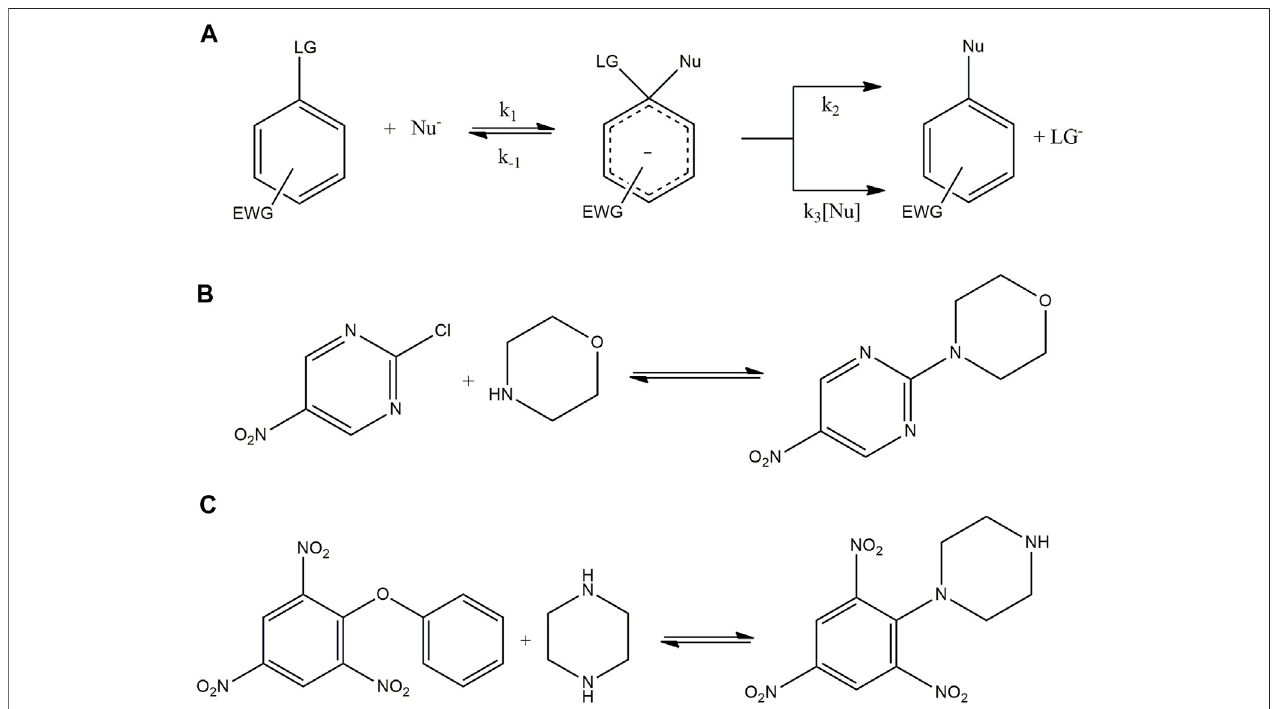
FIGURE7|(A) Generalmechanismforanucleophilicaromaticsubstitution.Thesubstratehasaleavinggroup(LG)andsomeelectronwithdrawinggroup(EWG)to favor the substitution. The nucleophile (Nu) attaches to the ring to form the Meisenheimer complex that can generate the desired product through a fi rst-order decomposition ( k 2 ) or a second-order decomposition with the help of a second molecule of nucleophile ( k 3 ). (B) Scheme for the product reaction between CNP and morpholine. (C) Scheme for the product reaction between TNPPE and